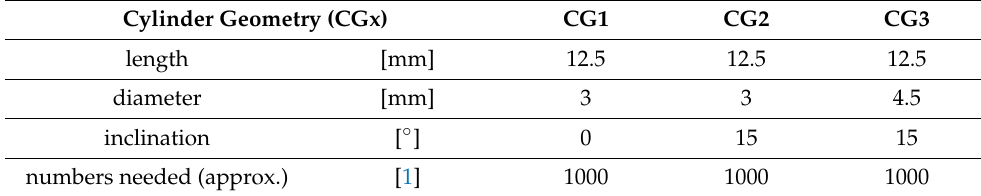
Table 1. Parameters for the three types of cylinders for the illustration